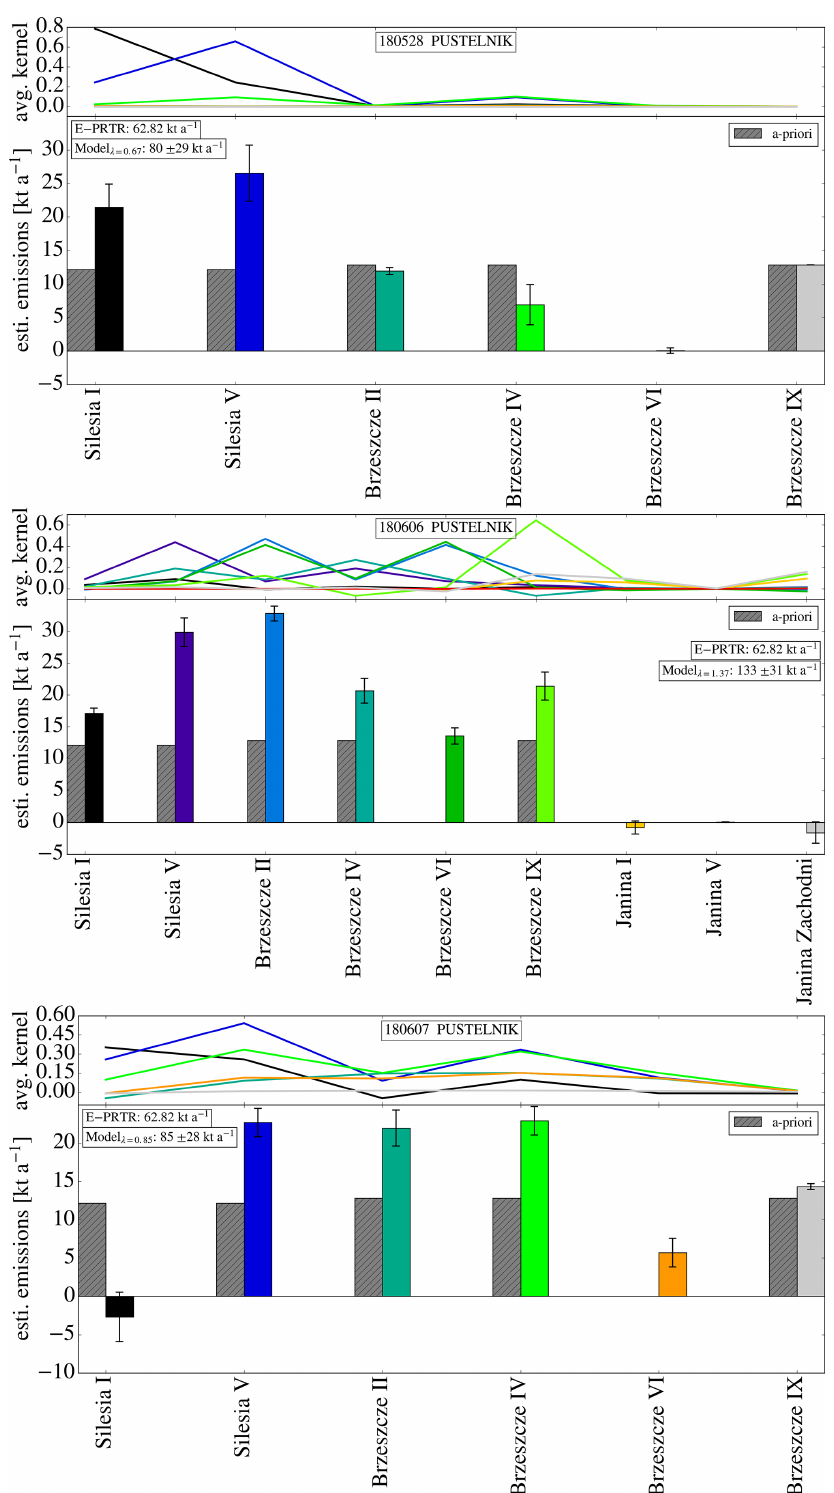
Figure 10. Shaft-wise emission estimates (lower sub-panels) for the three case studies at the southern station Pustelnik and the corresponding emissions averaging kernels (upper sub-panels). Colors of the shaft-wise emission estimates resemble colors of the emissions averaging kernel. Error bars contain atmospheric variability and observational uncertainty (measurement noise and background variability). Grey bars illustrate the a priori emission